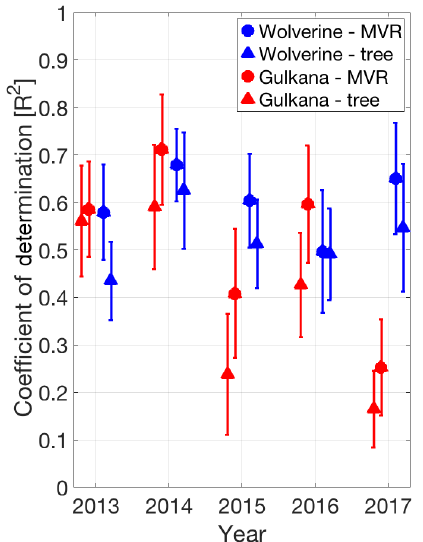
Figure 5. Median and standard deviation (error bars) of coefficient of determination (from 100 model runs) for both extrapolation ap- proaches (circles are MVR, triangles are regression tree) developed on training datasets and applied to test datasets. Symbols and error bars are offset from year for